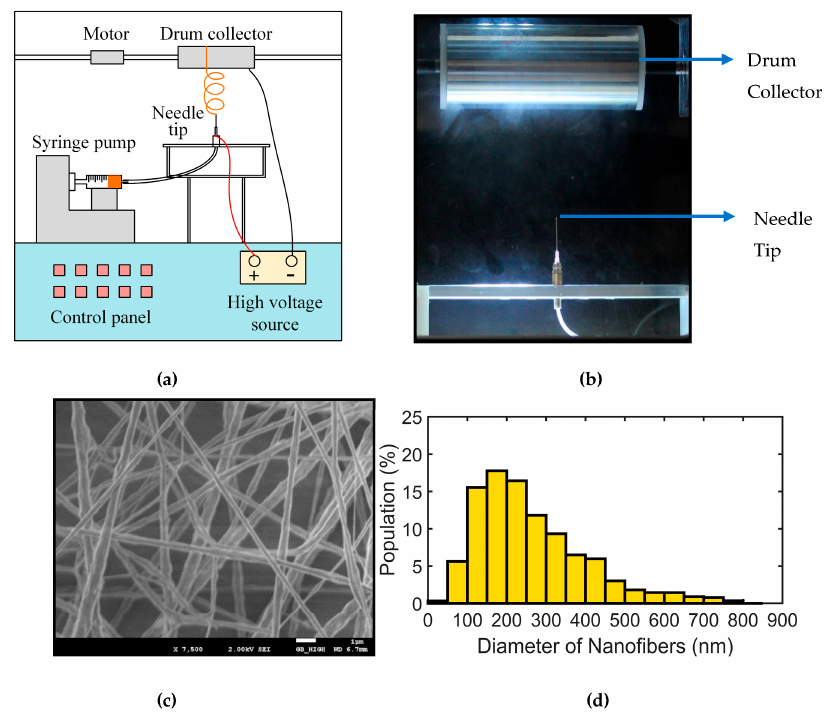
Figure 1. ( a ) Schematic of the electrospinning system used for formation of PVDF nanofibers; ( b ) Enlarged view of the needle and the drum collector arrangement of the electrospinning system; ( c ) SEM image of a sample of PVDF nanofibers collected from electrospinning; ( d ) Histogram of the nanofiber diameters present in the sample.